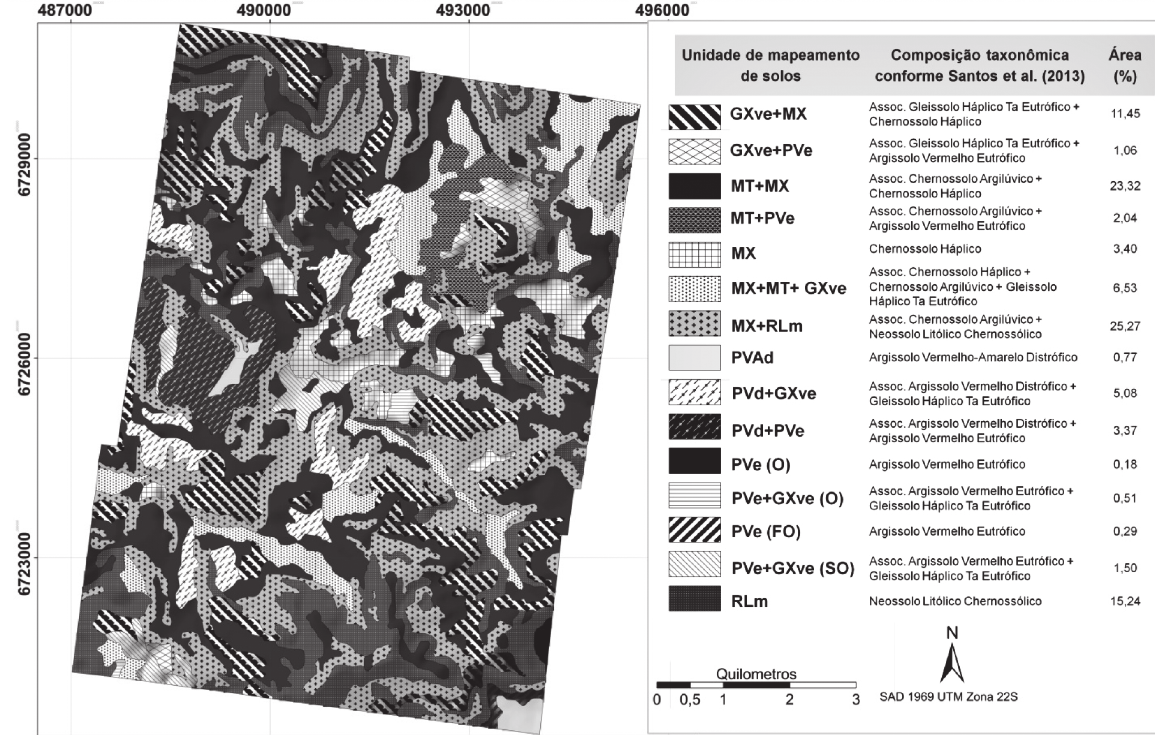
Figura 2. Mapa de solos do município de Dois Irmãos, Rio Grande do Sul. Fonte: Klamt et al.